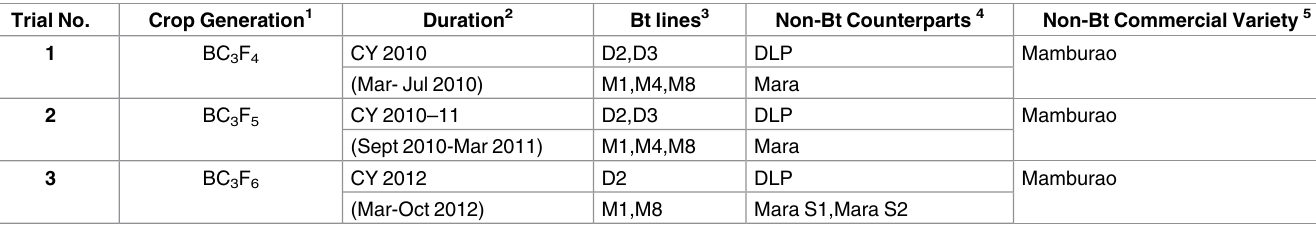
Table 1. Plant materials used in confined field trials. Trial